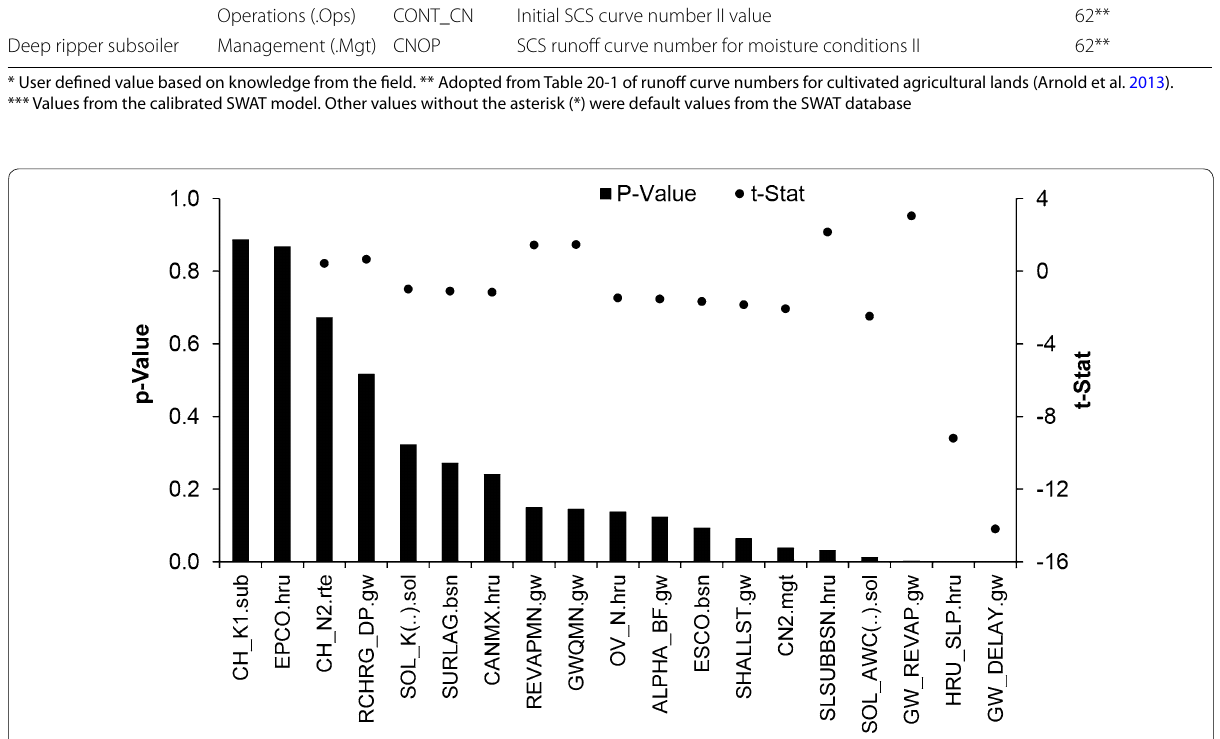
Fig. 10 The t-statistic and p values of the calibrated parameters of Ndembera River